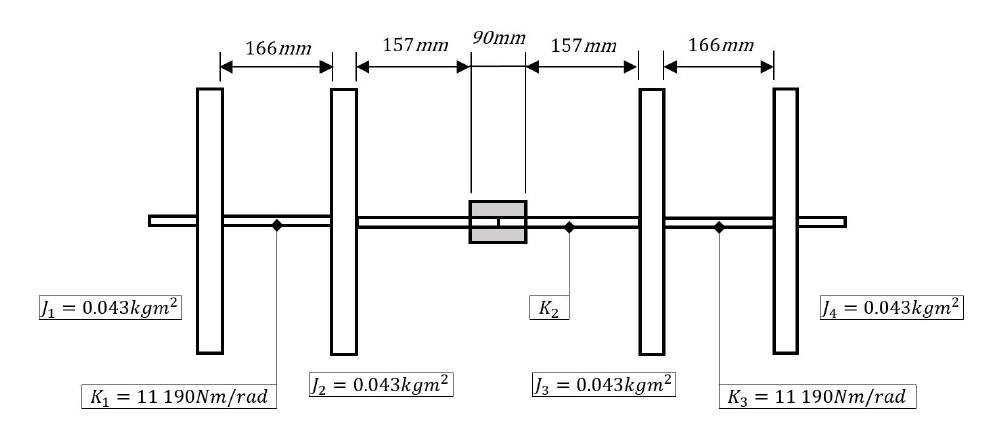
Figure 7. Schematic representation of the initial model to perform the analytical calculation of the first torsional eigenfrequency.